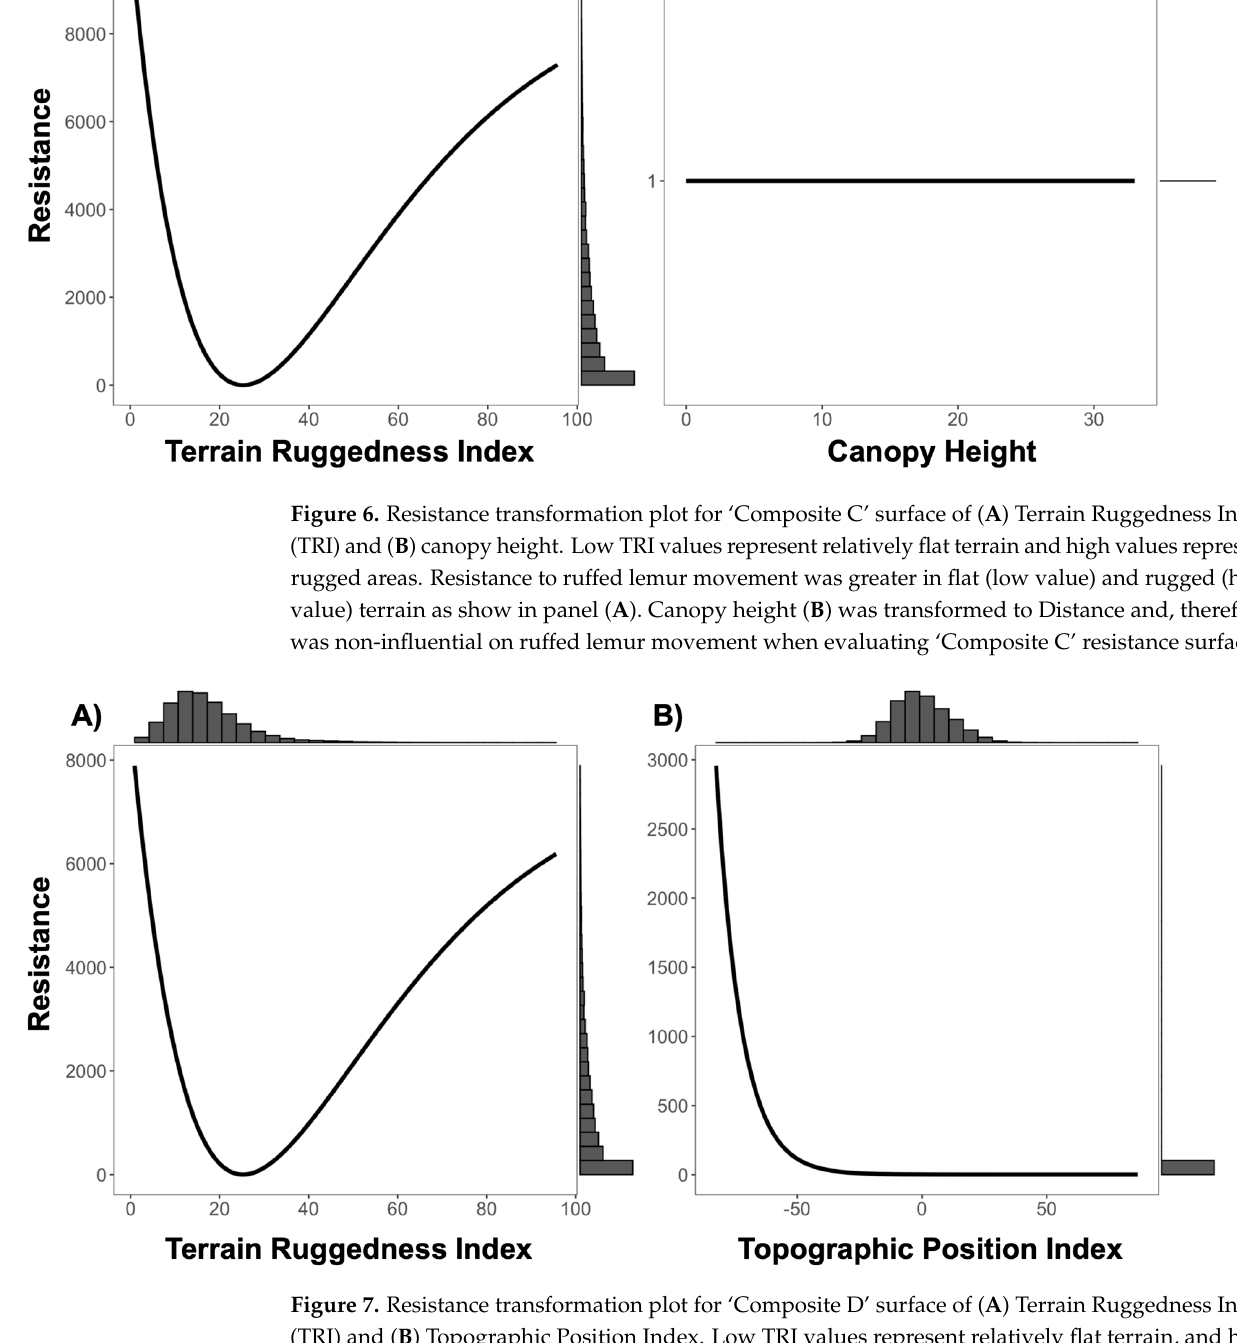
Figure 7. Resistance transformation plot for ‘Composite D’ surface of ( A ) Terrain Ruggedness Index (TRI) and ( B ) Topographic Position Index. Low TRI values represent relatively flat terrain, and high values represent rugged areas. Positive TPI values represent ridges, negative TPI values represent valleys, and flat terrain or areas of constant slope are represented by a TPI value near zero. Resistance to ruffed lemur movement was greater in flat (low value) and rugged (high value) terrain, as shown in panel ( A ). Resistance to ruffed lemur movement was lower for slopes leading to ridges and ridges, as shown in panel ( B ).